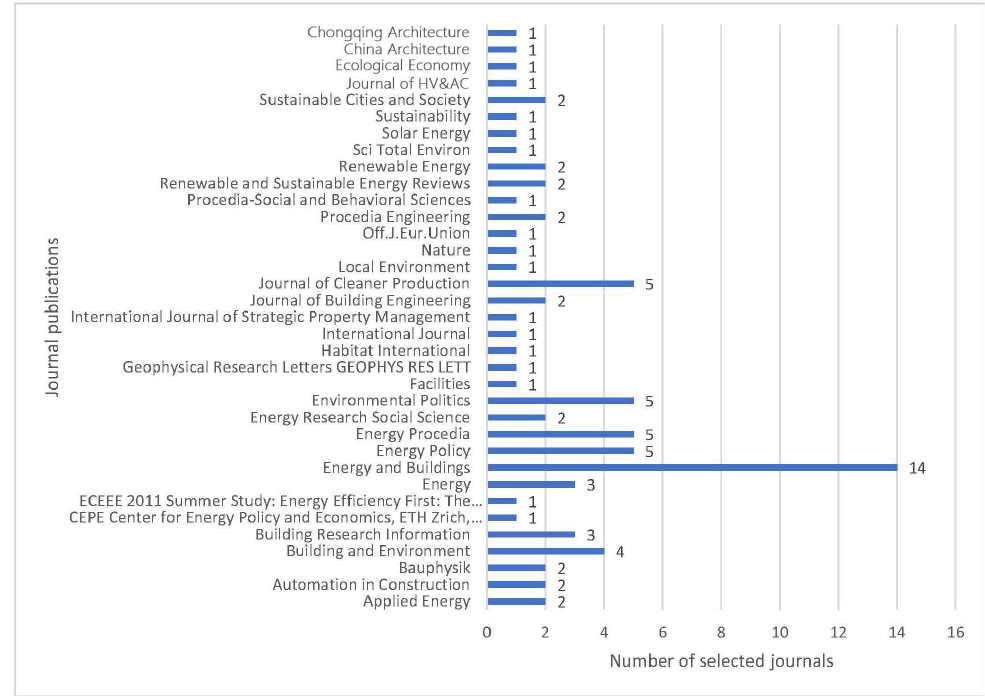
Figure 4. Number of cited publications.